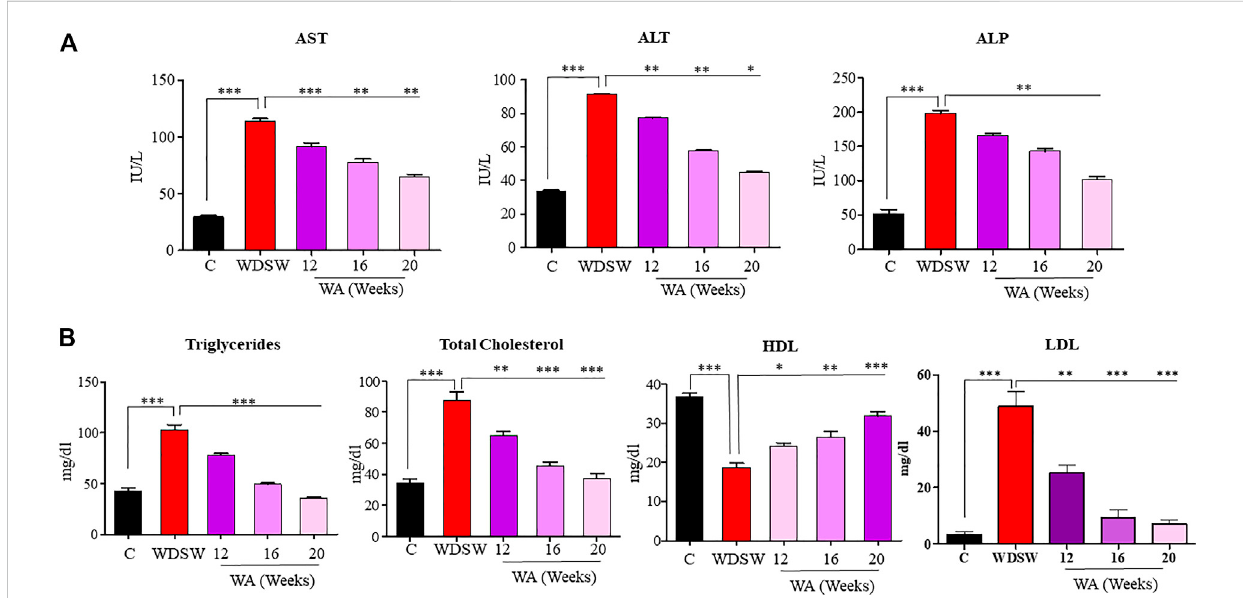
Withaferin A decreased diet-induced liver injury and dyslipidemia. Serum liver function tests: (A) aspartate aminotransferase (AST), alanine aminotransferase (ALT), and alkaline phosphatase (ALP). Serum lipid pro fi le: (B) triglycerides (TG), total cholesterol (TC), high-density lipoproteins (HDL), and low-density lipoproteins (LDL).